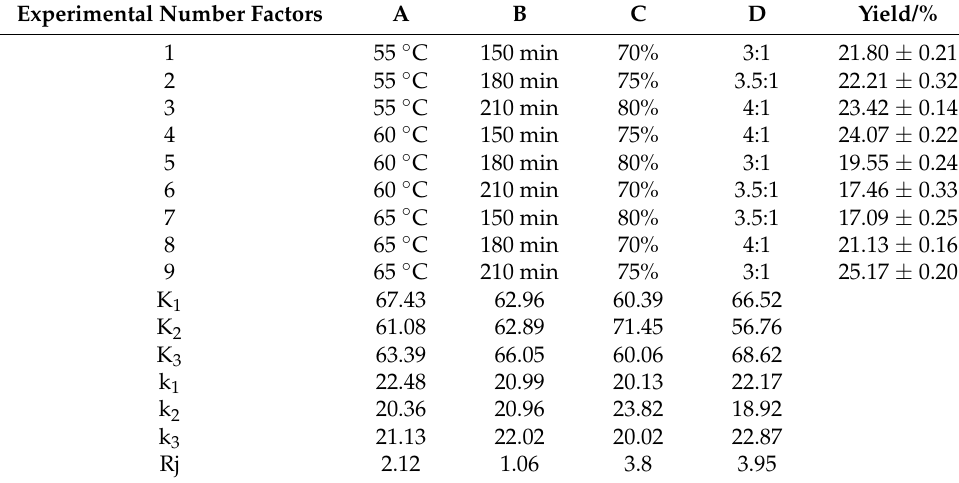
Table 5. Orthogonal test